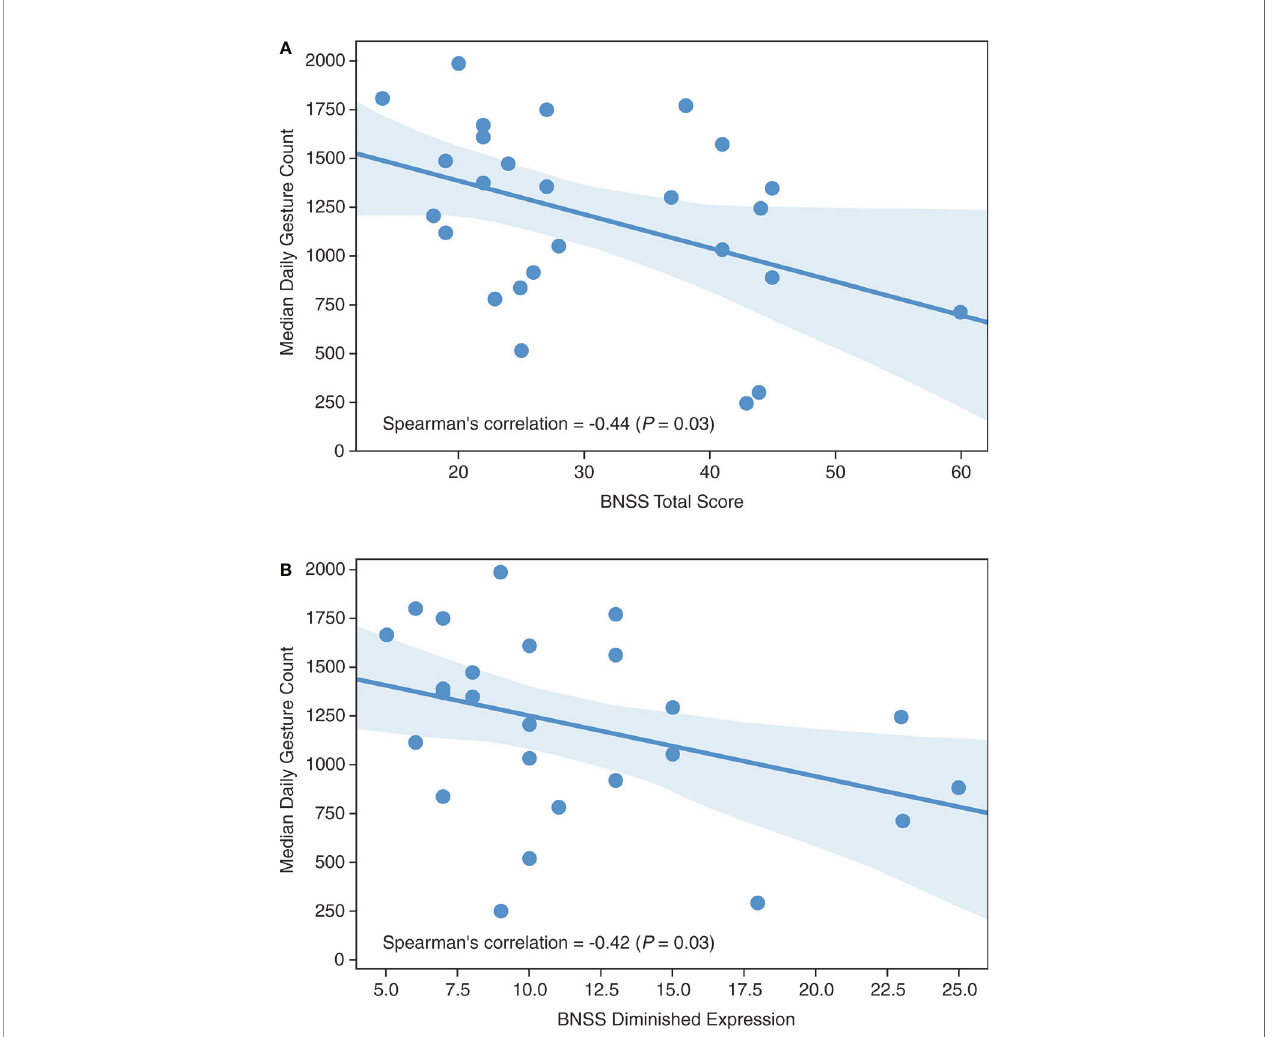
FIGURE 2 | Median daily gesture count versus (A) BNSS total score and (B) BNSS diminished expression. BNSS, Brief Negative Symptom Scale.